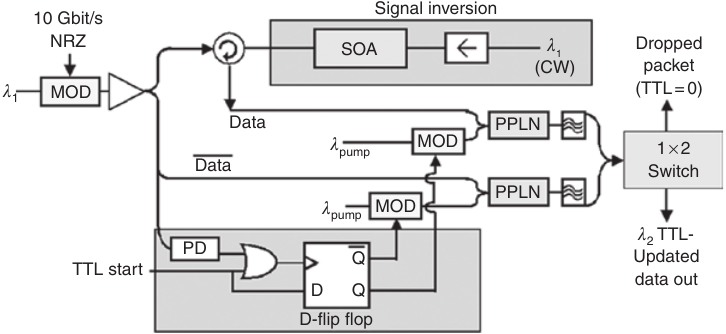
Figure 11: Optical packet hop-count